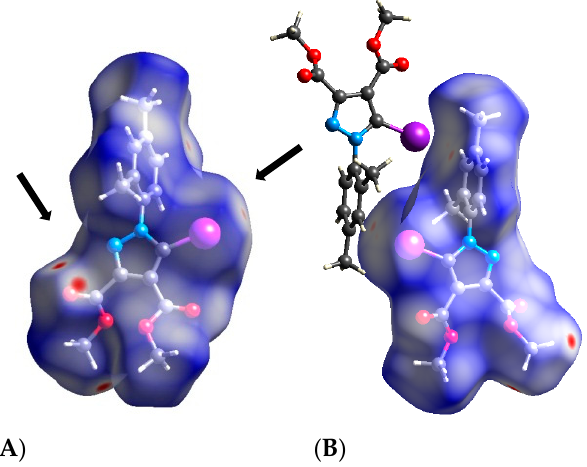
Figure 13. Hirshfeld surface of compound 2 and the exemplified dimer formed by the C–I ⋯ π bond: ( A ) close contacts as red spots on the Hirshfeld surface; ( B ) exemplified dimer formed by the two inversed molecules of 2 generated by the C–I ⋯ π contact. Halogen bond parameters: C-I bond length: 2.071 Å; I ⋯ Cg distance: 3.580 Å; (sum of the vdW radii: 3.68 Å [58]; ∠ C-I ⋯ Cg: 171.3° (Cg is the centroid of the bond formed by C-3 and C-4 of the phenyl ring).